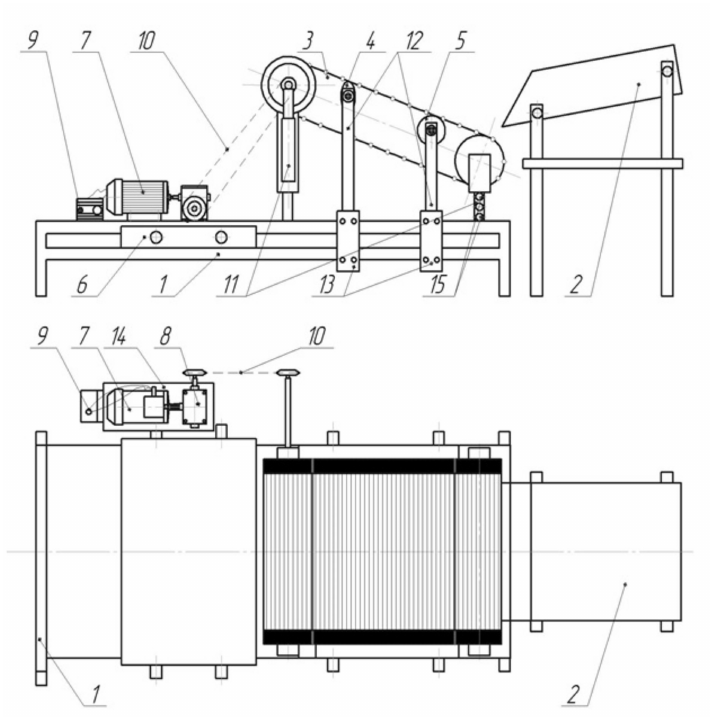
Figure 10. Diagram of a laboratory installation for determining the influence of technological parameters of a separating rod elevator on the quality indicators of the separation of a pile of root crops and onions: 1 frame; 2 container for preliminary placement of the pile; 3 separating rod elevator; 4 elliptical shaker; 5 cylindrical roller; 6 tarpaulin of separated products; 7 electric motor; 8 single- stage gearbox; 9 frequency converter; 10 chain transmission; 11 support racks; 12 shaker and support roller racks; 13 connecting bracket; 14 support plate; 15 technological openings.